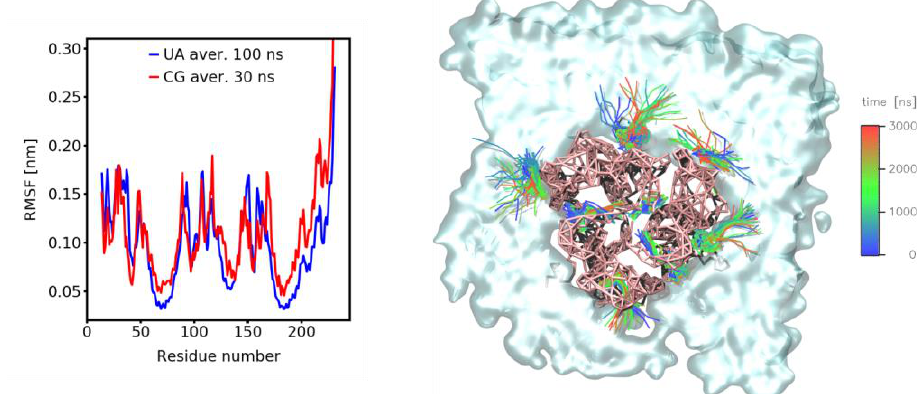
Fig. 1. Comparison of the root mean square fluctuations (RMSF) of our new GC model for the LHCII monomer (red line) with atomistic simulations (blue line; left panel). Top view of the LHCII trimer embedded in thylakoid membrane (right). The protein backbone is colored pink; the membrane is drawn as cyan surface. Eight selected chlorophyll molecules are depicted over the whole simulation time of 3 μs to show the differences of their flexibility. Each chlorophyll molecule is depicted every 125 ns. The color bar indicates the corresponding simulation